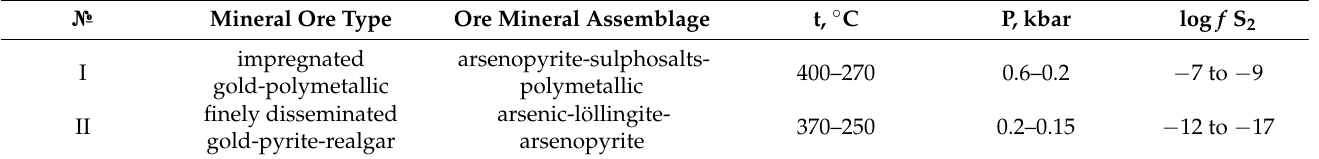
Table 3. Arsenopyrite-bearing mineral assemblages of the Vorontsovka gold